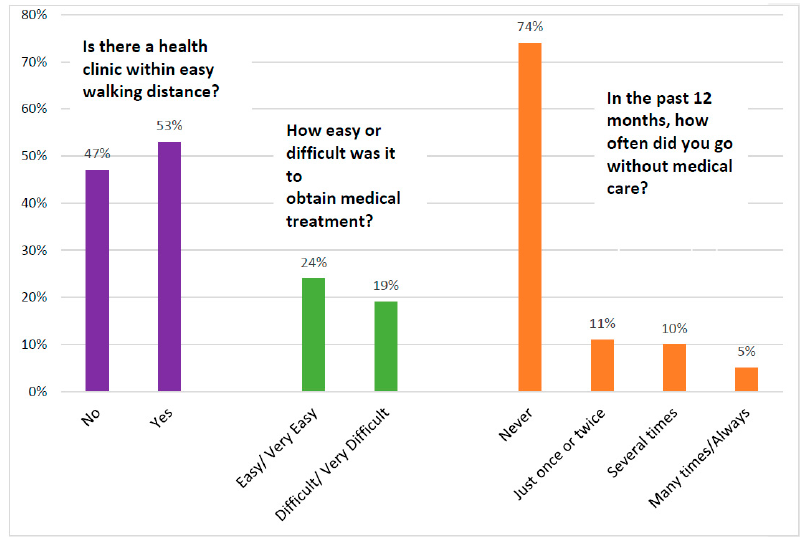
Figure 1. Availability of health services; 2014/2015: Source: Author’s construct.